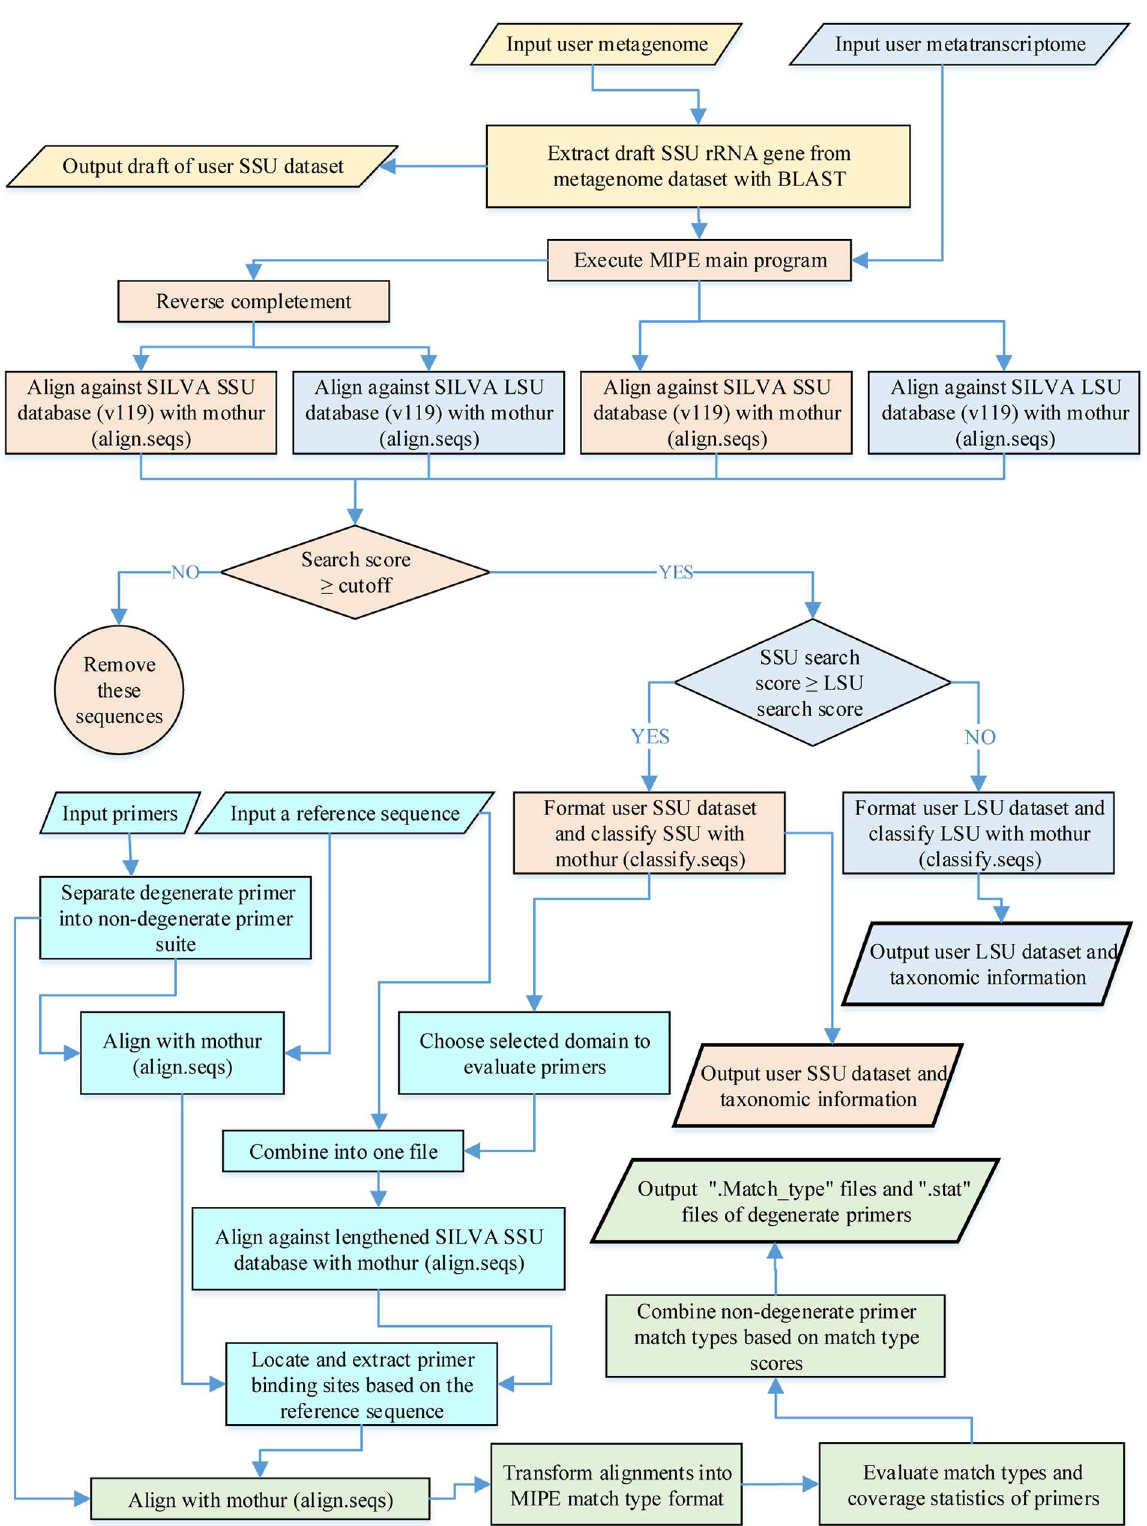
Fig 1. Work flow of MIPE. The part shown with a yellow background is the preprocessing stage of MIPE. The orangebackground details Stage I of the main program of MIPE, specificallysequencescreeningand taxonomy of a metagenome and a